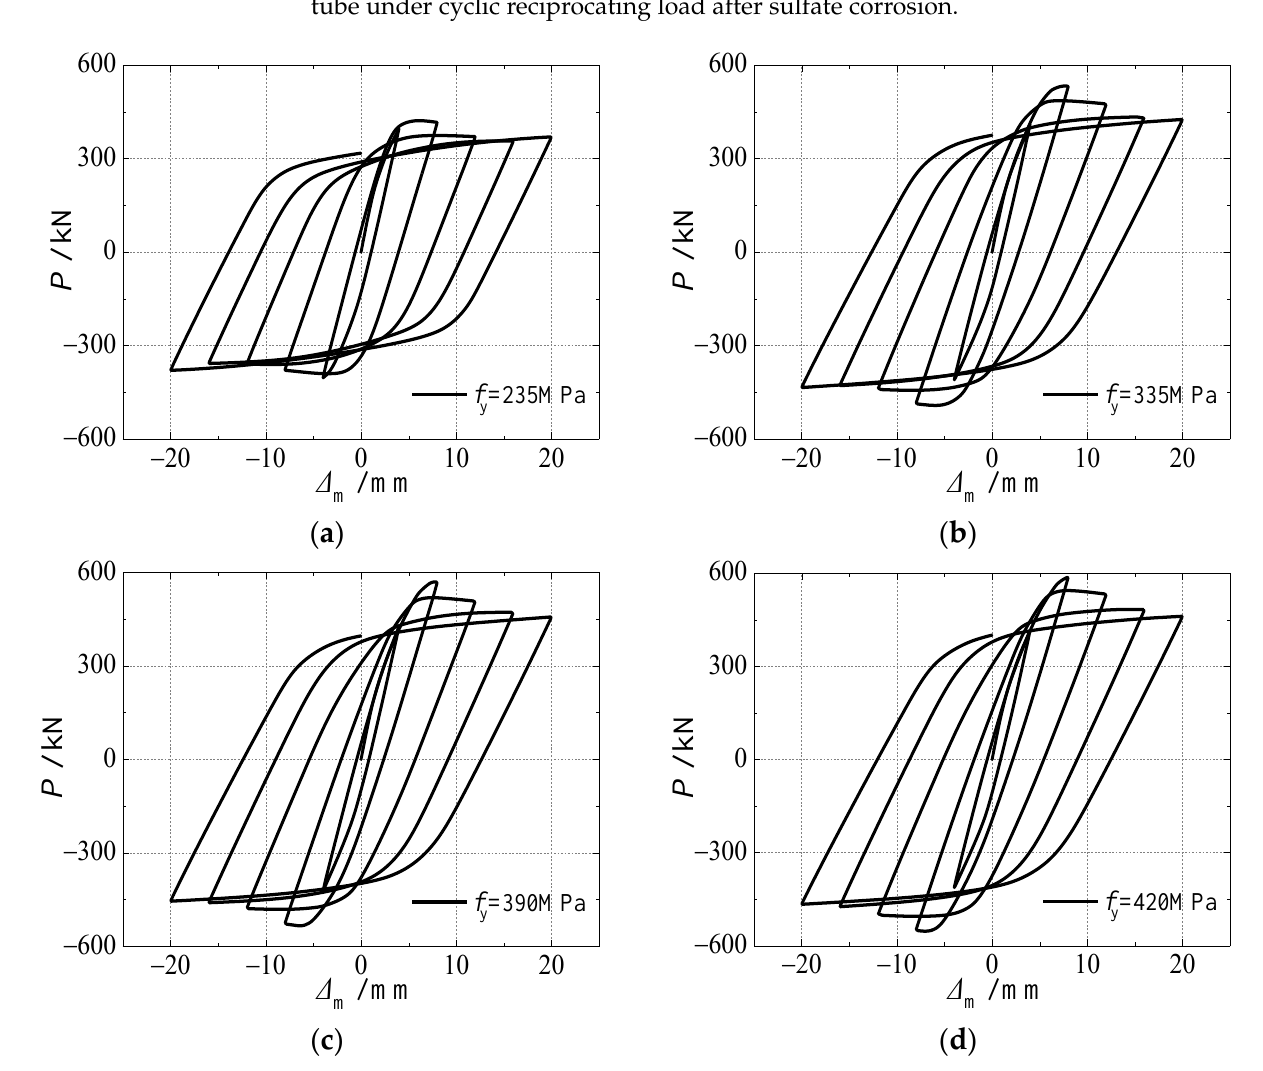
Figure 13. Effect of yield strength of steel tube on hysteretic curve. ( a ) f y = 235 MPa; ( b ) f y = 335 MPa; ( c ) f y = 390 MPa; ( d ) f y = 420 MPa.